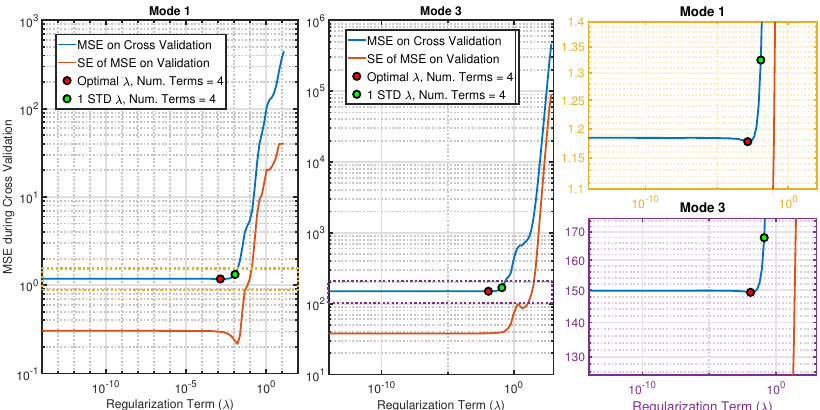
Figure 3. Mean squared error (MSE) and standard error (SE) of a 1,3-mode reduced order model (ROM) when using k-fold cross validation for each λ value. The two subplots on the right are zoomed in portions of the plots on the left and center.